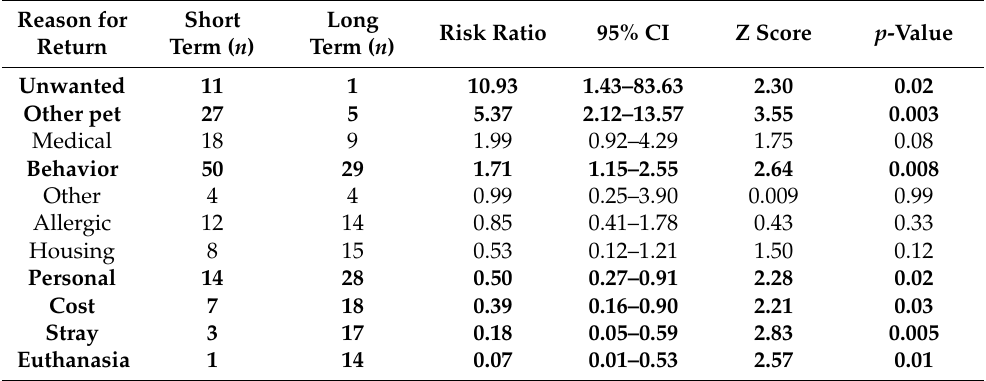
Table 2. Relative risk difference of common reasons for return in the short and long term. Bold indicates significant at the p < 0.05 level.